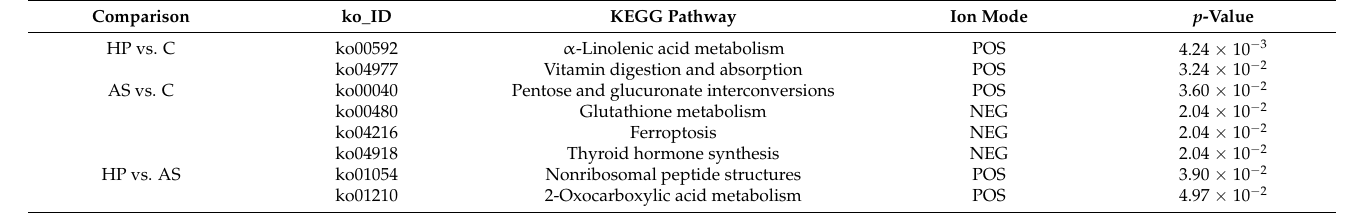
Table 6. KEGG pathway enrichment of metabolites with statistically significant abundance